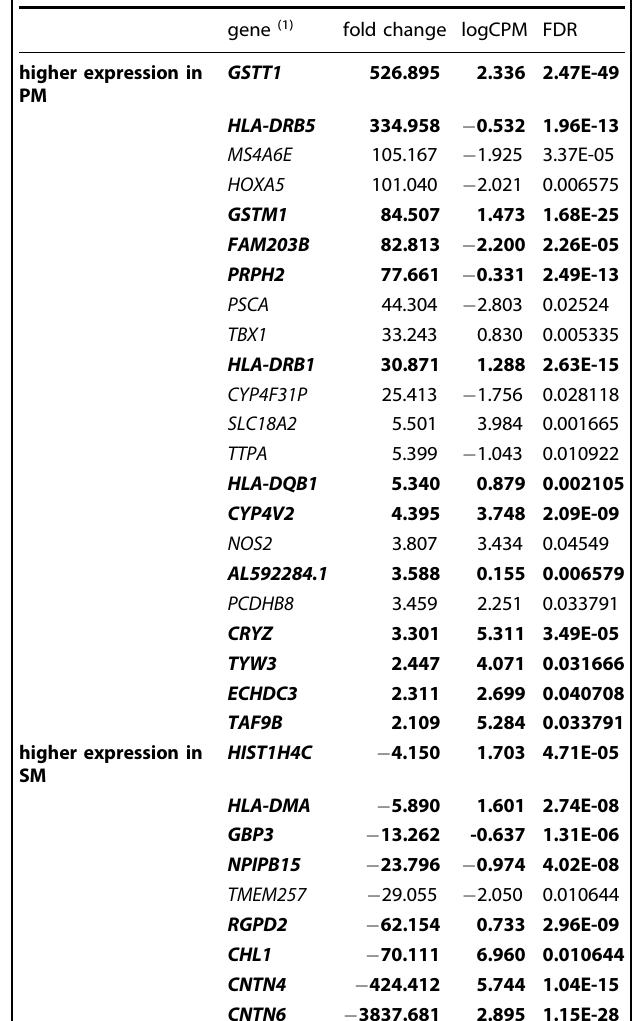
Table 3. Genes signi fi cantly differentially expressed at Day 11. Table 4. Genes signi fi cantly differentially expressed at Day